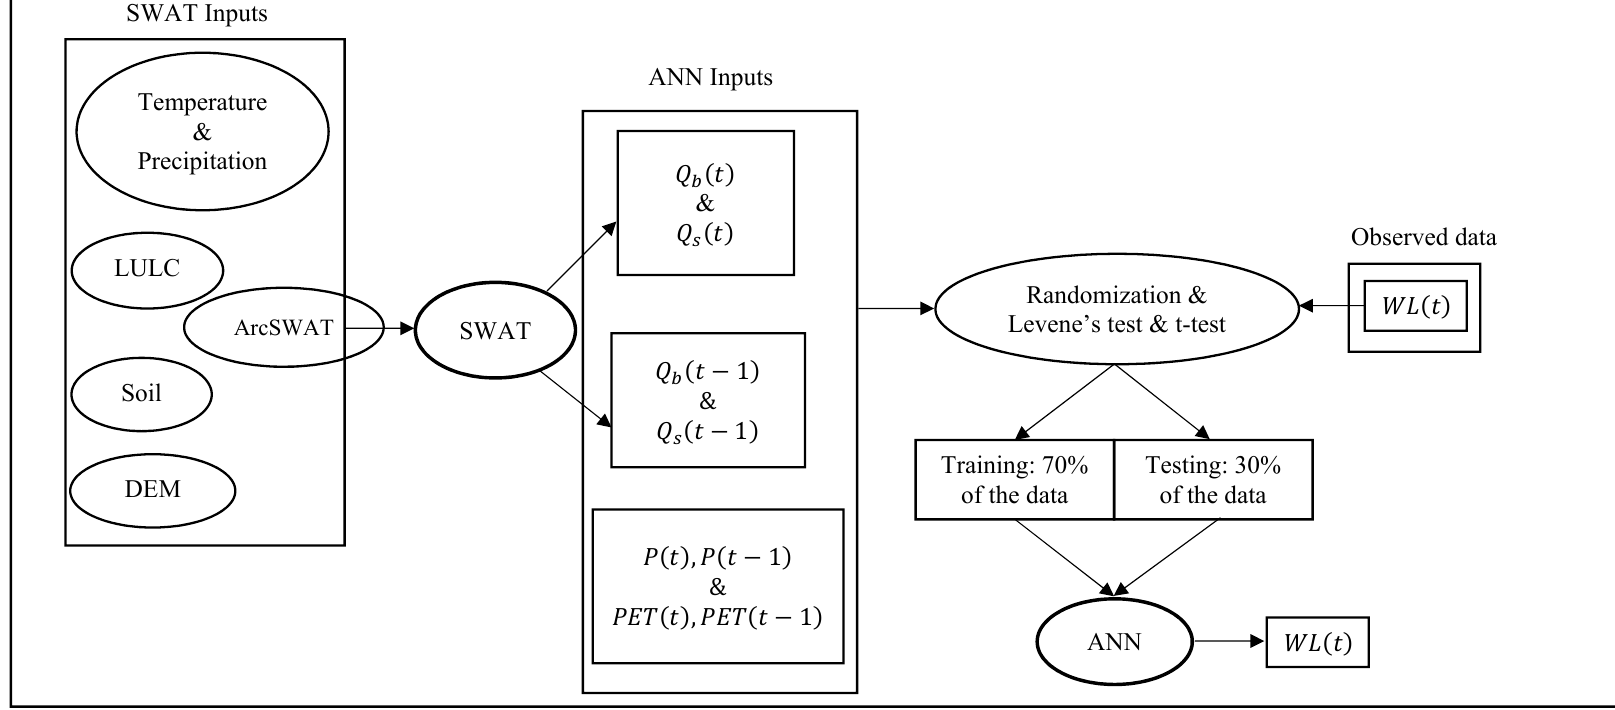
Figure 23. Model development flowchart. (cid:1843) , (cid:1843) , (cid:1842) and (cid:1842)(cid:1831)(cid:1846) denote baseflow, stormflow, precipitation and potential Figure 3. Model development flowchart. Q b , Q s , P and PET denote baseflow, stormflow, precipitation, and potential evapotranspiration, respectively. Data were (cid:3029) (cid:3046) randomly selected in which Levene’s test and t -test (Rezaeianzadeh et al. [3]) were used to obtain the optimal datasets for training and testing evapotranspiration, respectively. Data were randomly selected in which Levene’s test and t-test (Rezaeianzadeh et al. 2015) were used to obtain the optimal datasets for training and testing phases. DEM refers to digital elevation model.